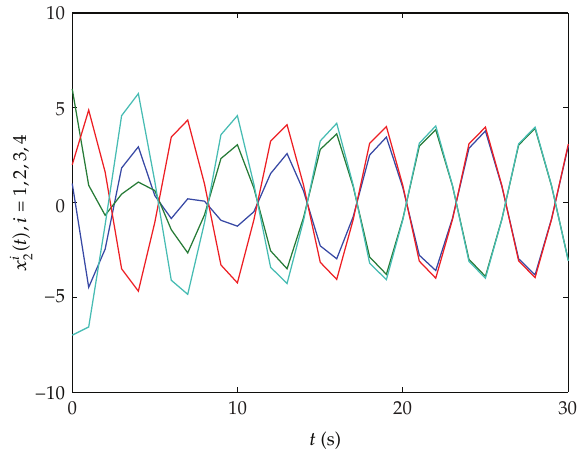
(cid:6) t (cid:7) , i (cid:9) 1 , 2 , 3 , 4 for G 2